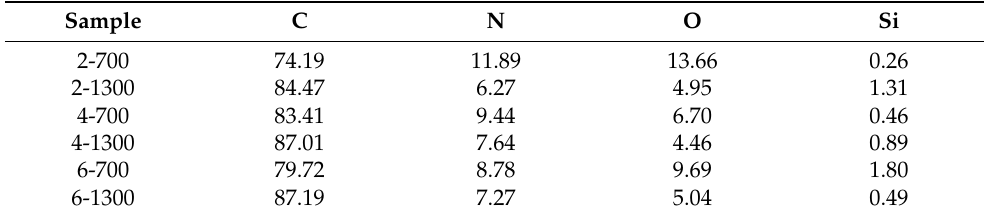
Figure 5. SEM images of samples ( a ) 2-20, ( b ) 4-20, ( c ) 6-20, ( d ) 2-700, ( e ) 4-700, ( f ) 6-700, ( g ) 2-1300, ( h ) 4-1300, and ( i ) 6-1300. Table 3. EDS of lignite samples prepared at HTHP.